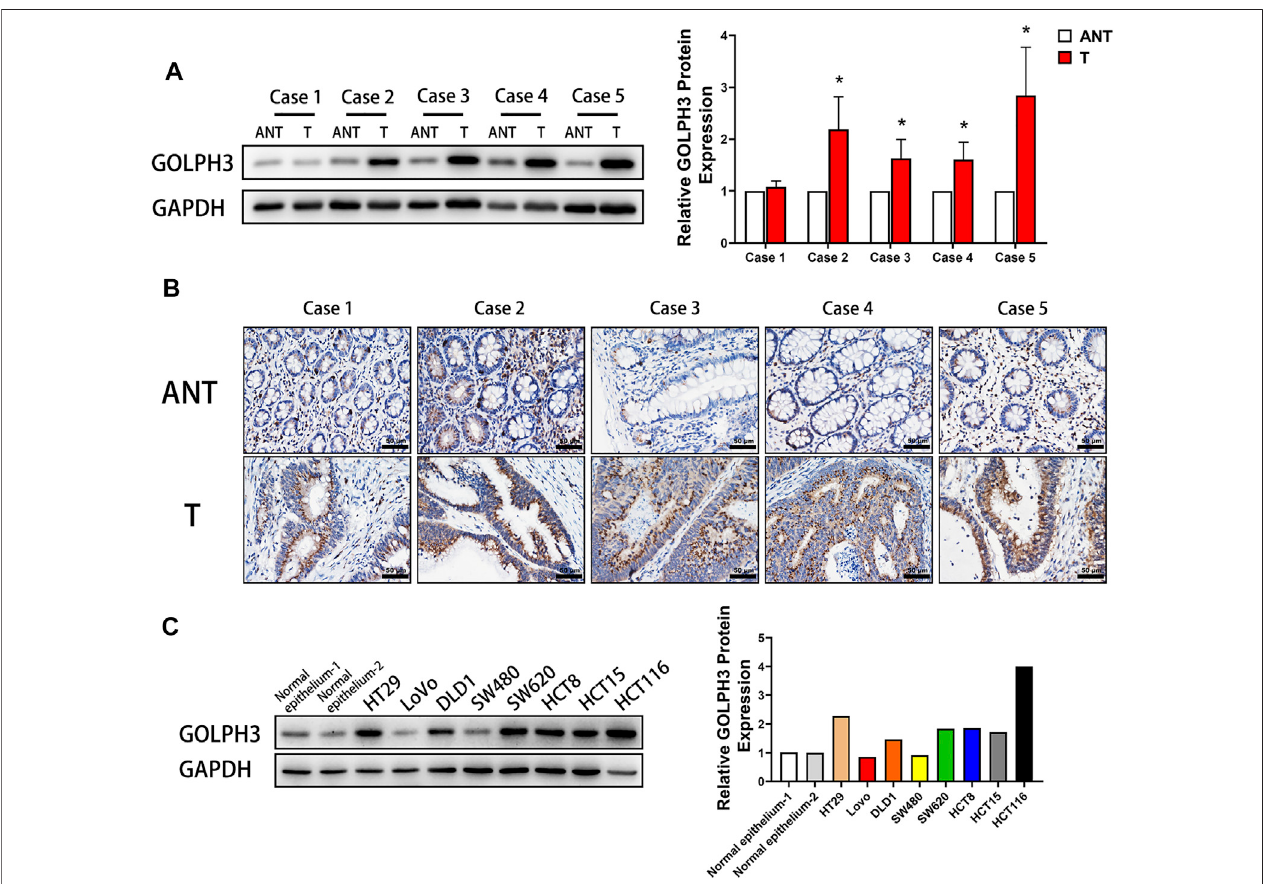
FIGURE 1 | High expression of GOLPH3 in CRC and colon cancer cell lines. (A) GOLPH3 protein levels were analyzed in 5 cases of CRC tissues (T) and matched adjacent non-cancerous tissues (ANT) by Western blotting. The bands of GOLPH3 protein were quanti fi ed by densitometry and normalized to GAPDH protein. (B) Immunohistochemical staining for GOLPH3 in 5 cases of CRC tissues and matched adjacent non-cancerous tissues. (C) The expression of GOLPH3 in different colon cancer cell lines were measured using Western blotting. The bands of GOLPH3 protein were quanti fi ed by densitometry and normalized to GAPDH protein. For (A , C) , results were reproduced in three independent experiments, and representative immunoblots are shown. Scale bar, 50 µm * p < 0.05, *** p < 0.001.